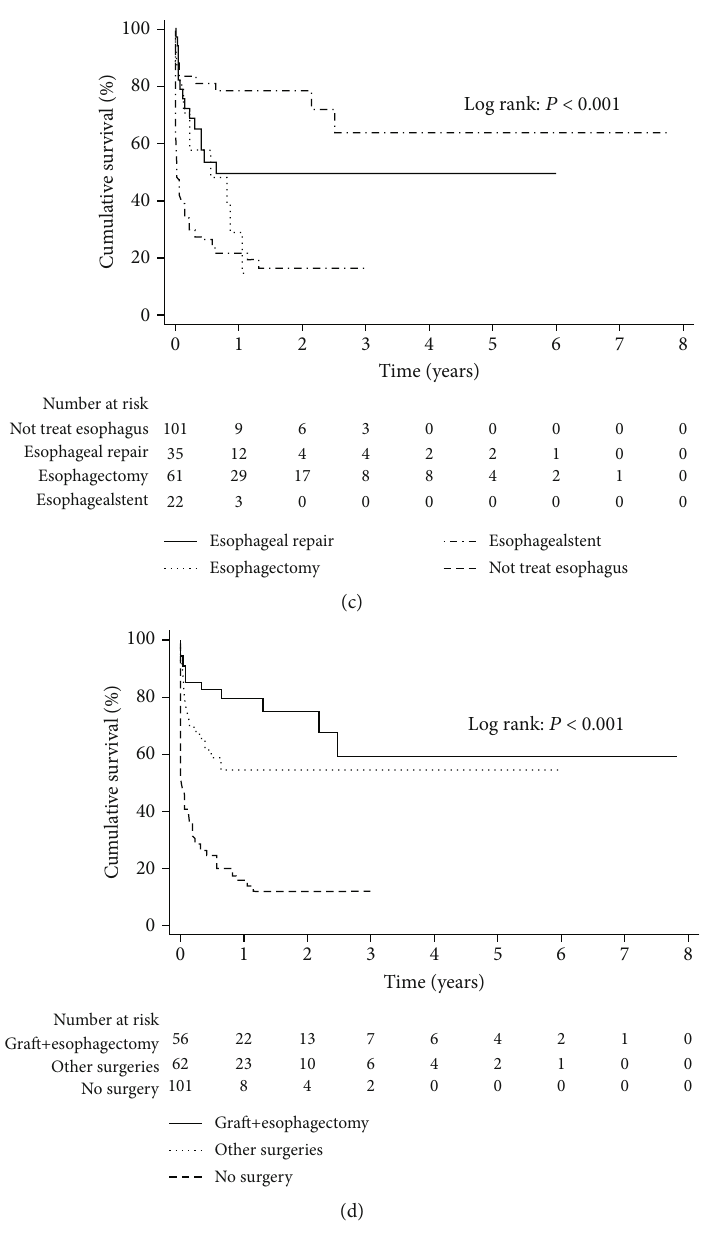
Figure 2: Overall survival of patients with aortoesophageal fi stula (AEF). (a) Patients with AEF who underwent surgery for aortic or esophageal lesions had a signi fi cantly better prognosis compared to nonsurgical patients ( P < 0 : 001 ). (b) Patients who were underwent graft replacement or graft replacement combined with TEVAR had a better prognosis than patients who received no treatment for aortic lesions (both P < 0 : 001 ). (c) Patients who underwent esophagectomy had better long-term survival compared to patients who underwent esophageal repair, esophageal stent, or no treatment ( P = 0 : 040 , P = 0 : 001 , and P < 0 : 001 , respectively). (d) Survival analysis con fi rmed better long-term survival of patients who underwent aortic graft replacement or esophagectomy compared to those who received other surgeries or treatments ( P = 0 : 043 , P < 0 : 001